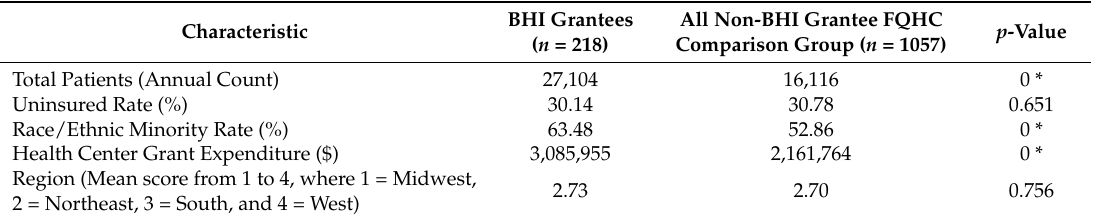
Table 1. Summary Statistics: Behavioral Health Integration (BHI) Grantees vs. All-Non-BHI-Grantee Federally Qualified Health Center (FQHC) Comparison Group at Baseline.